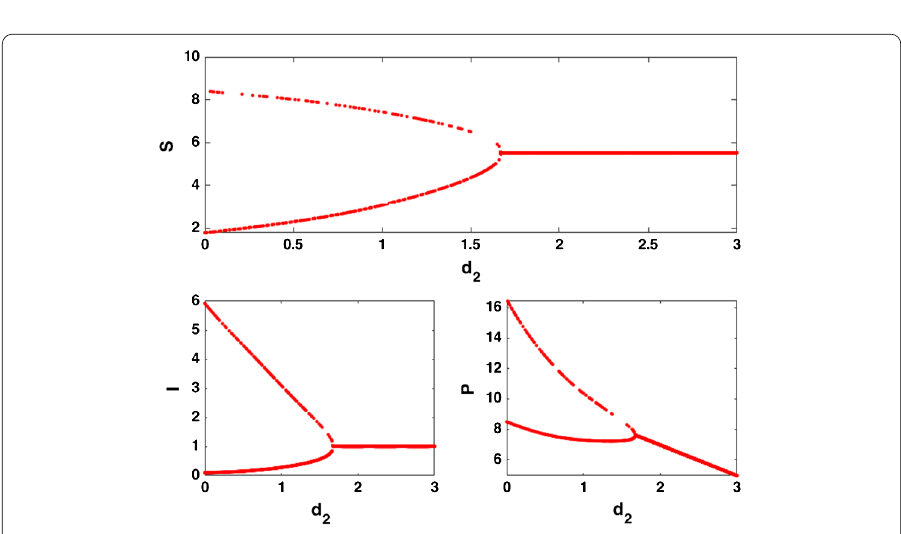
Figure 14 Bifurcation diagram of the fractional-order model (3) with respect to the infected prey’s death rate ( d 2 ) when q =